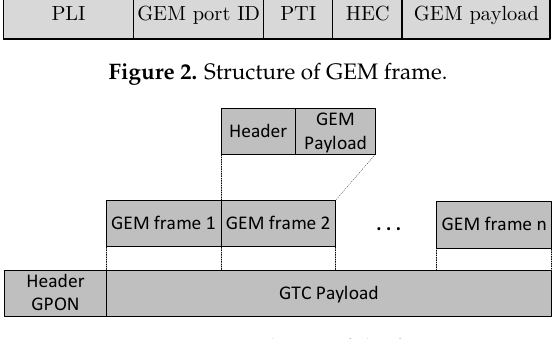
Figure 3. Encapsulation of the